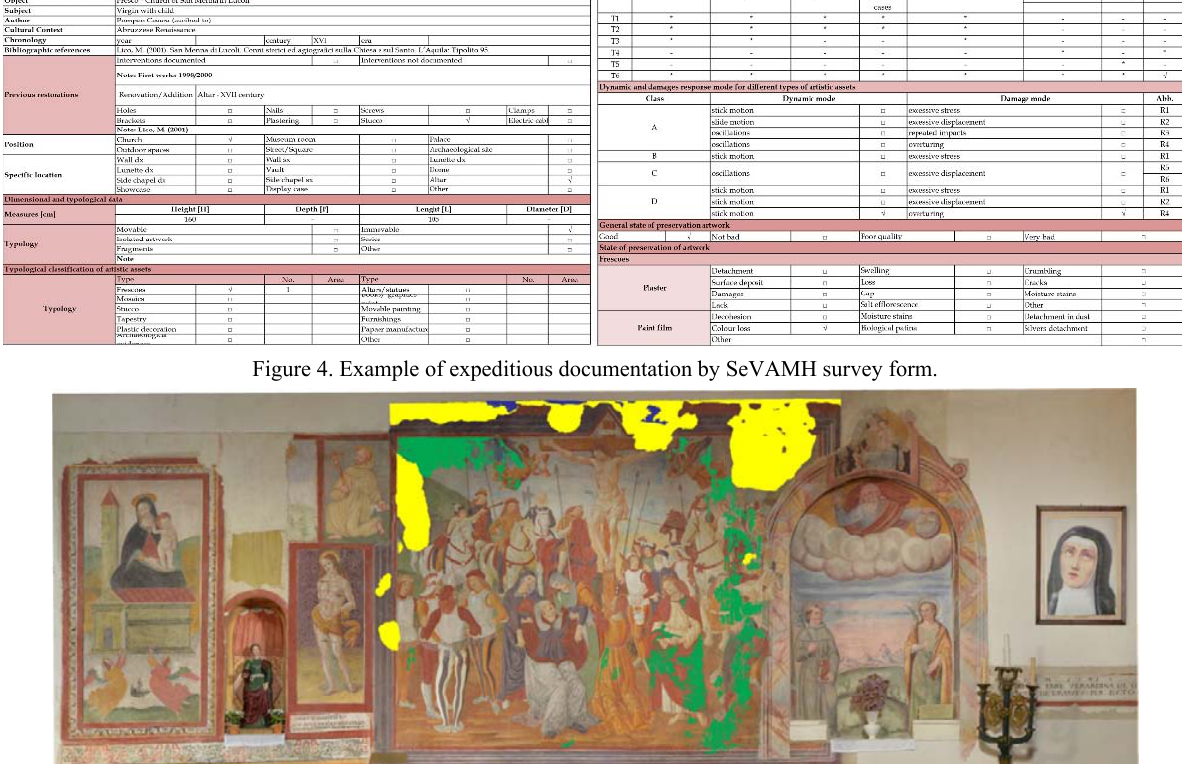
Figure 5. Degradation and alteration forms detected on the Crucifixion ascribed to Saturnino Gatti through SeVAMH